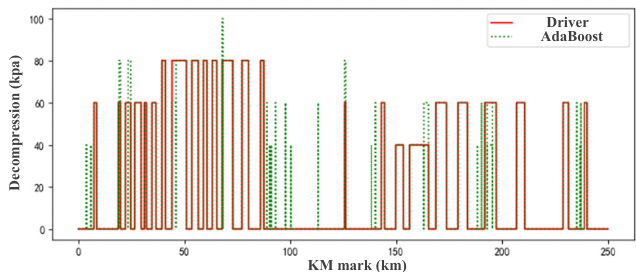
Figure 12. Comparison of the air brake output.